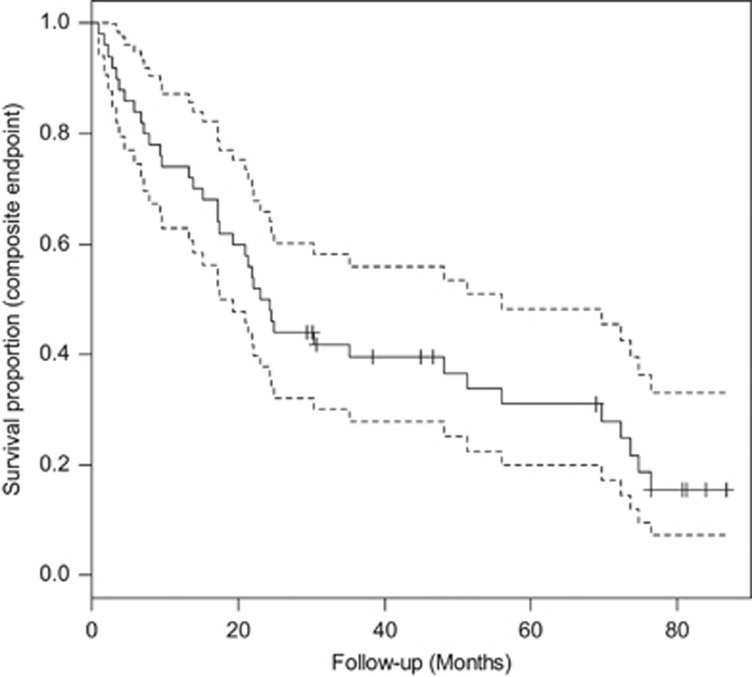
Progression-free survival for the whole cohort of 50 patients.